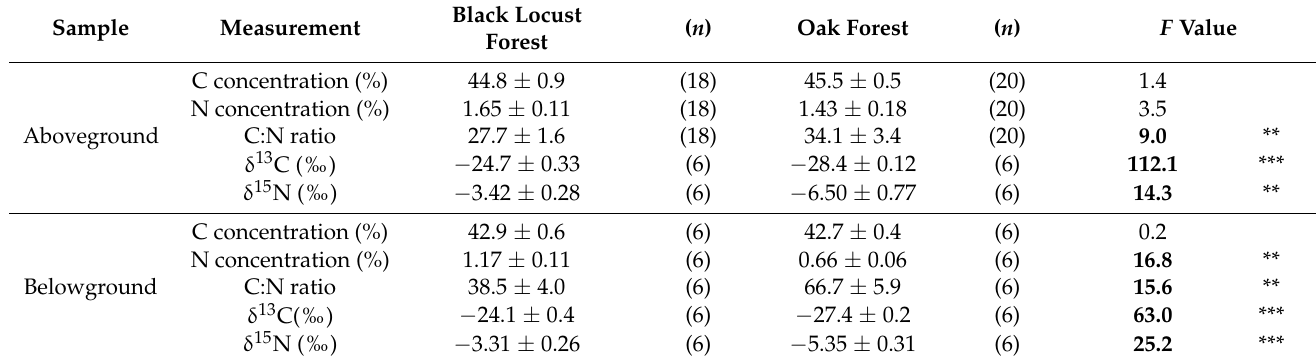
Table 2. Size and chemical properties (mean ± SE) of wild seedlings collected in the black locust forest and in the oak forest. ( n ) shows the number of samples. On the right are F -values and p -values (** p < 0.01, *** p < 0.001) based on the ANOVA for LM with the forest (the black locust forest or the oak forest). For the leaf C and N of wild seedlings collected on different occasions, LM for the forest type and recording occasion was used. For the size and other chemical properties of wild seedlings collected on one occasion, LM for forest type was used. The significant results were